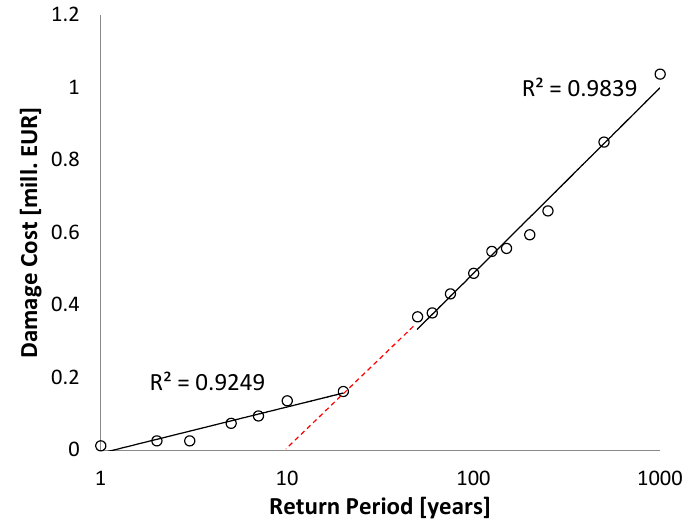
Figure 12. Accounting for the shift in the log-linear relation for the study area in Aarhus.